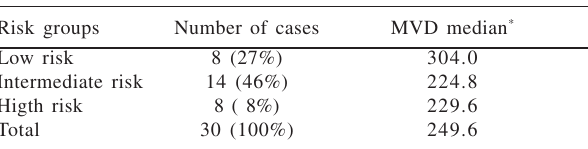
Figure 3 – MVD (microvessels/mm 2 ) comparison between groups without and with metastasis, considering all patients (A) and after follicular subtype exclusion in both groups (B). * Mann-Whytney test. Table 3 - The MDV median of risk groups according to AMES 4 prognostic